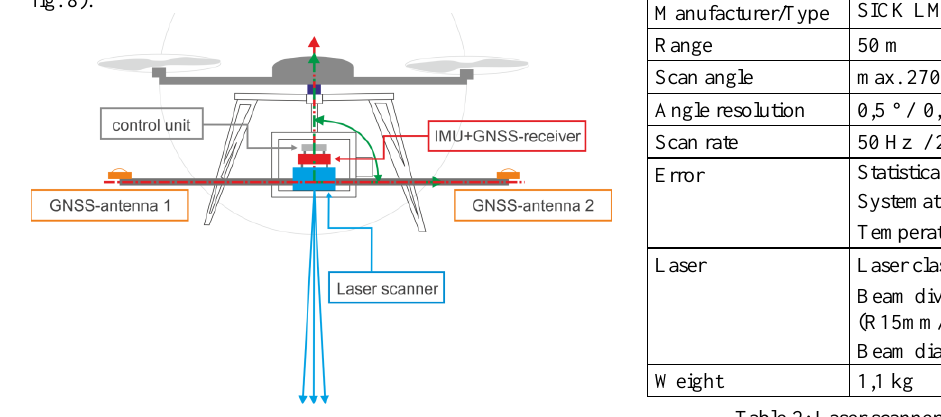
Figure 8. Side view with the measuring system The gimbal compensates the movements of the flight platform and keeps the sensor platform in an approximate horizontal position during the data collecting and the IMU detects every movement in a sufficient accuracy (see Fig. 9).